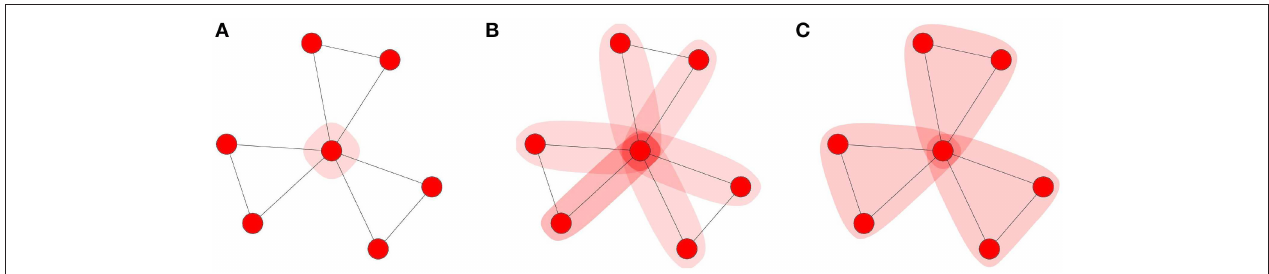
FIGURE 3 | Approximation schemes: (A) MF, (B) PA, and (C) CA scheme. The shaded regions represents how much of the local topology is used to approximate the number of infected neighbors of an updating node.